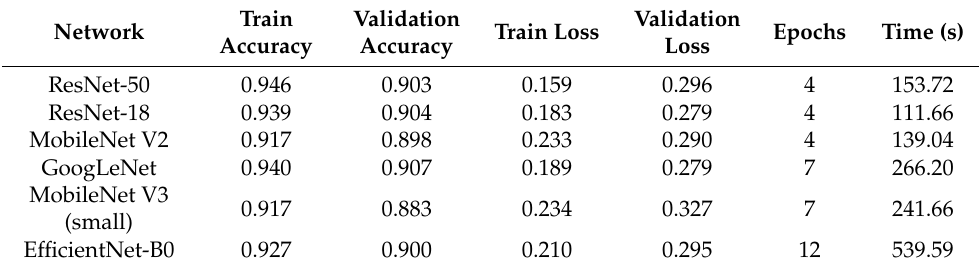
Table 5. Test performance